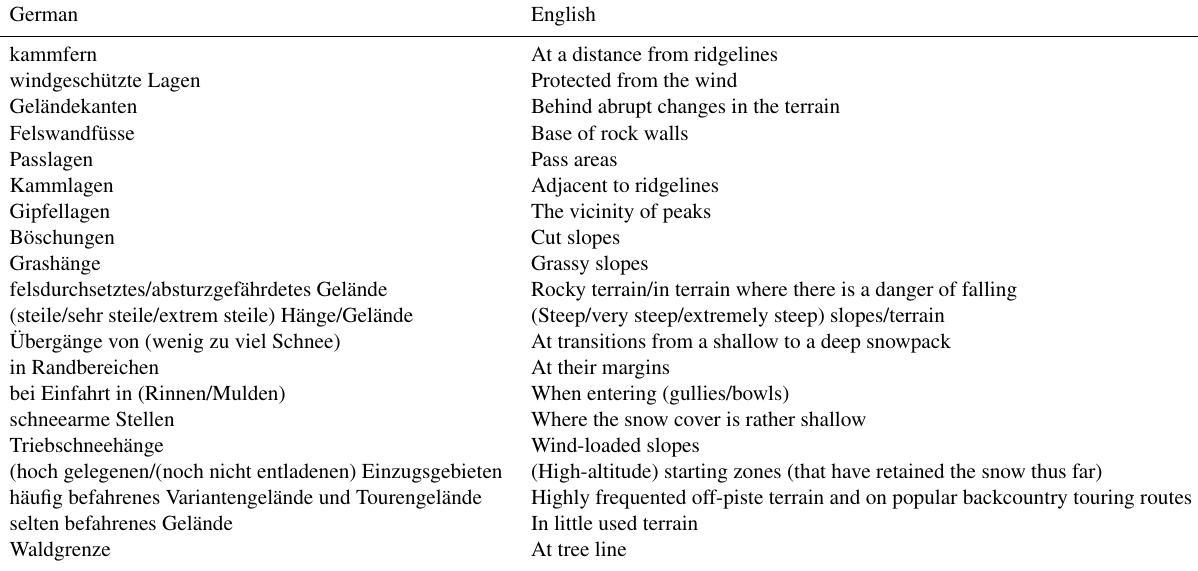
Table A5. Text values providing location-specific information. Numerous combinations and variants exist. Not shown are values describing aspect and elevation as these are normally shown in the aspect–elevation plot (Fig. 1b) and values which were not used in the analyzed forecasts. This list should therefore be seen as an example rather than an exhaustive